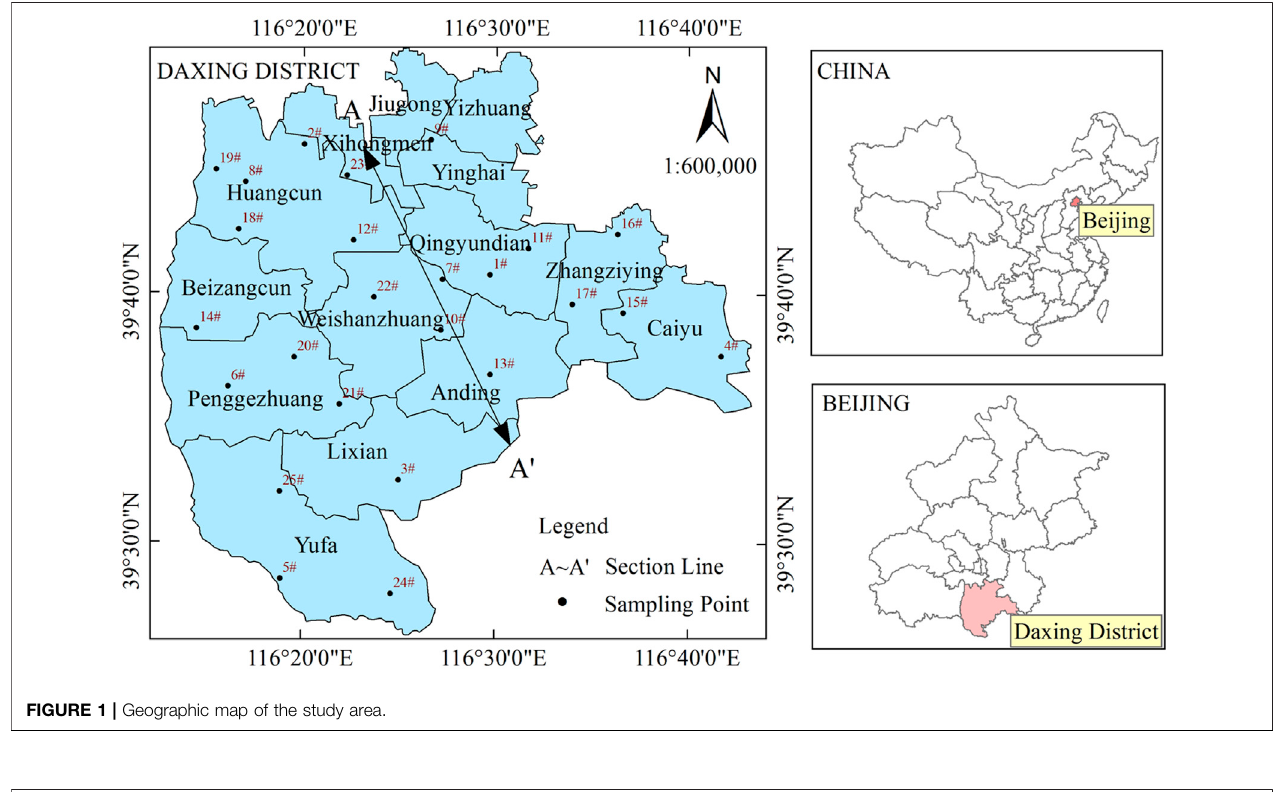
FIGURE 1 | Geographic map of the study area.